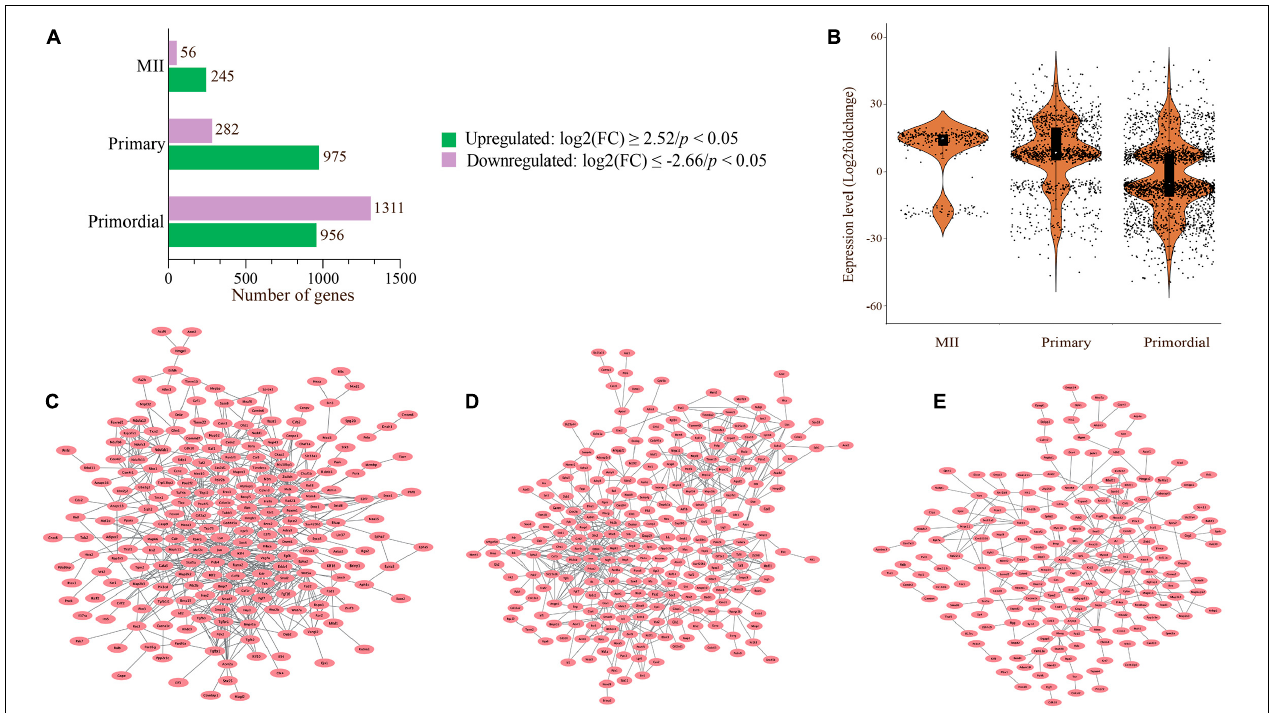
FIGURE 6 | Visualization of SDEGs by bar chart, violin plot, and cloud networks. (A) The number of SDEGs (adjusted p -value < 0.05) represented by the bar chart. Differential expression analysis and normalization were performed using DESeq2 in R. (B) Violin plot representing the distribution of SDEGs in oocytes from primordial and primary follicles and MII oocytes in the in vivo and in vitro groups. Each dot shows the log2 fold change values in oocytes. (C–E) Network of 302 selected SDEGs in oocytes from primordial (C) and primary (D) follicles and MII oocytes (E) in the in vivo and in vitro groups. Different expression patterns are shown for the in vivo- and in vitro -grown MII oocytes and oocytes from primordial and primary